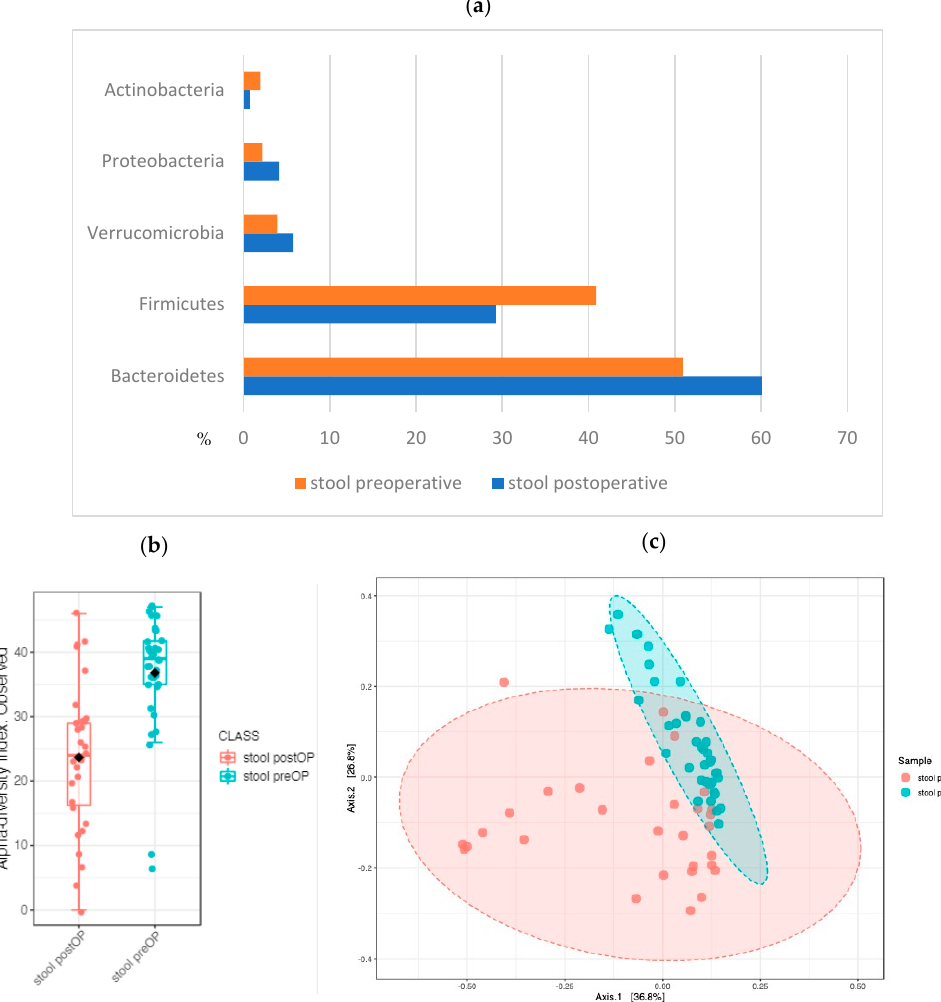
Figure 12. The stool microbiome preoperative and postoperative showed major differences: ( a ) Phylum level abundance profile of preoperative and postoperative samples. Comparison of pre- and postoperative stool revealed significant differences at the genus level: ( b ) alpha diversity and ( c ) beta diversity, ( p < 0.001).